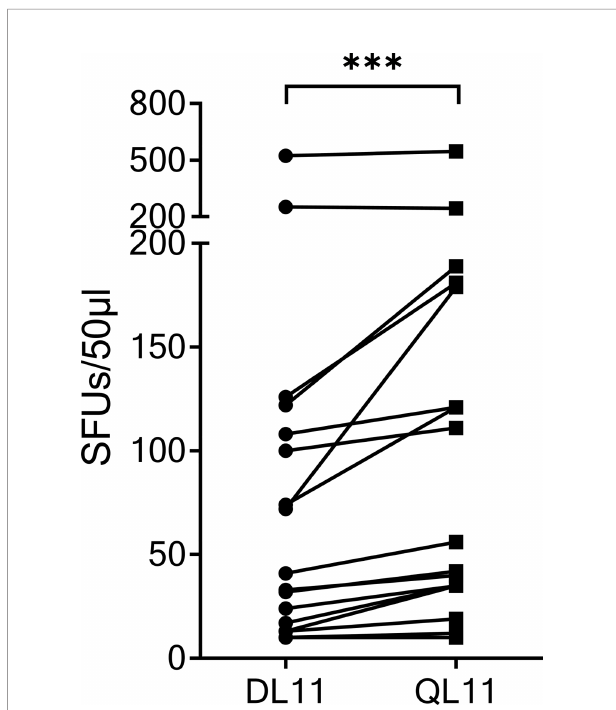
FIGURE 3 | The homologous OC43 peptide OC43-QL11 was recognized better than the SARS-CoV-2 peptide SCoV-DL11. 17 T-cell lines that responded to SCoV-DL11 were tested for recognition of SCoV-DL11 and OC43-QL11 in a g -IFN ELISpot. 50µl of each T-cell suspension were stimulated with either SCoV-DL11 or OC43-QL11 at a fi nal peptide concentration of 20µg/ml. T-cell suspension without addition of peptides were used as negative controls to determine background responses. Shown are SFUs after subtraction of background. *** Wilcoxon Matched-Pairs Signed Ranks Test: p <